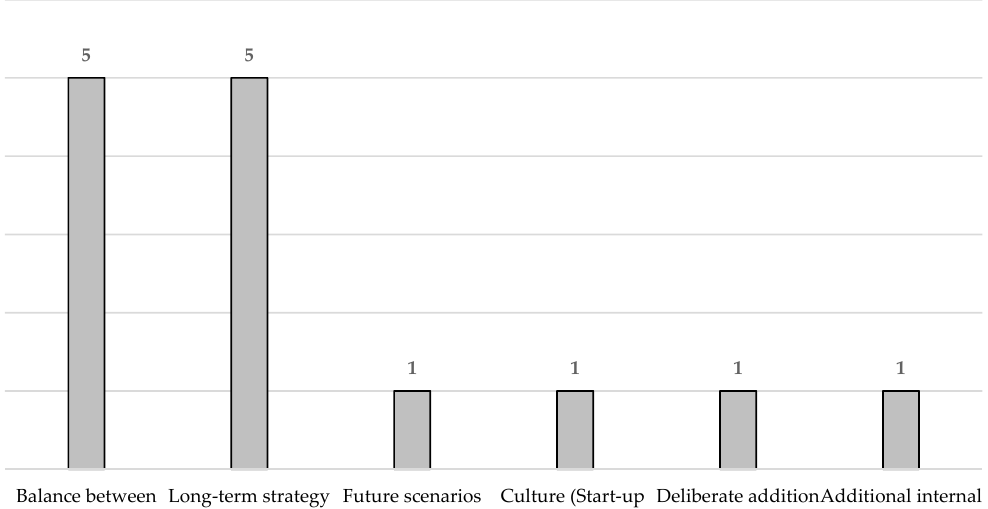
Figure 5. Ways to address uncertainty existing in long-term sustainability efforts.